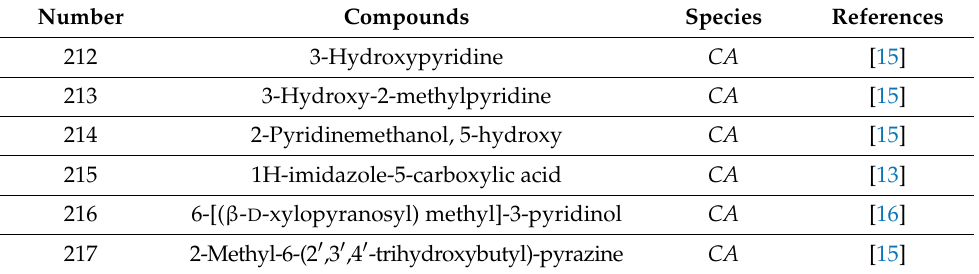
Table 4. Alkaloids compounds isolated from CA , CB , and CW .